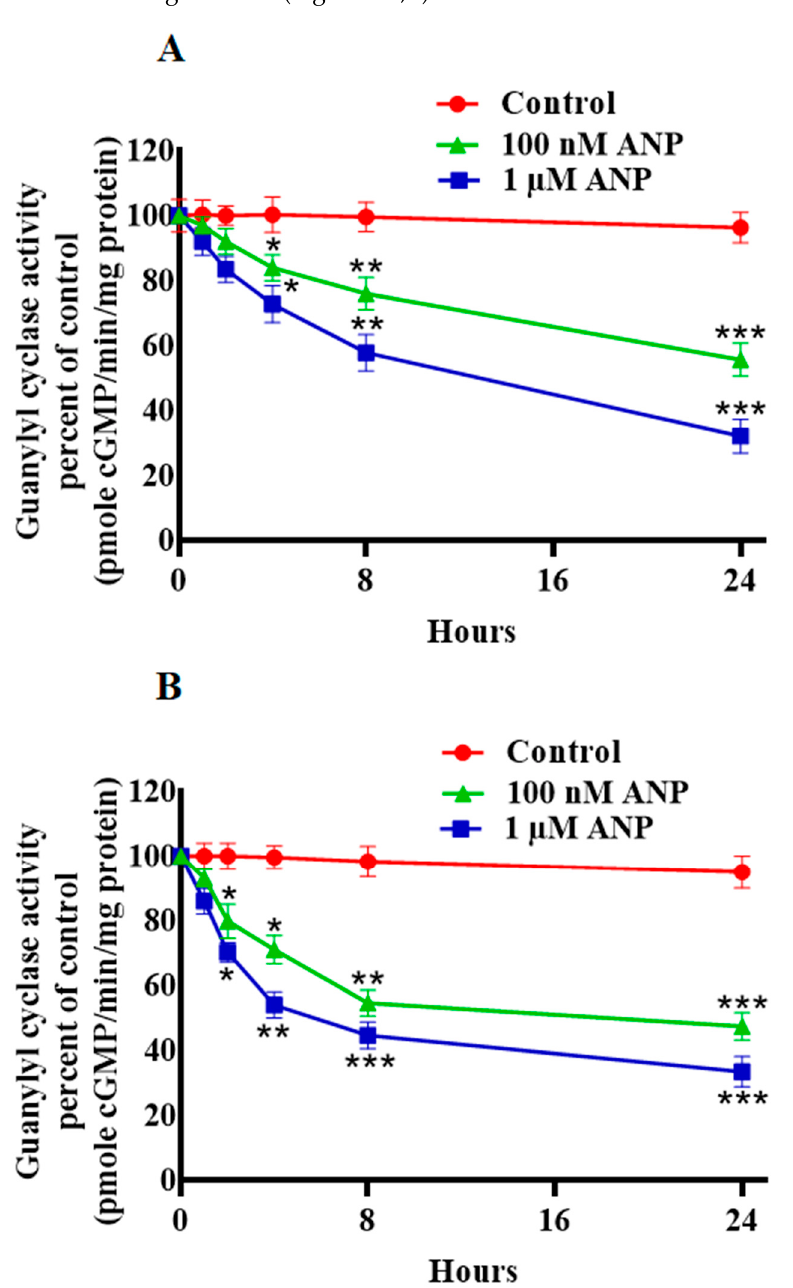
Figure 3. Effect of ANP pretreatment on guanylyl cyclase activity in HEK-293 cells and MA-10 cells. ( A ) HEK-293 cells and ( B ) MA-10 cells were treated with 100 nM ANP for 0, 8, 16, and 24 h. Cells were incubated with glycine acetate buffer (pH 3.8) for 2 min, plasma membranes were prepared. GC activity was determined as described under the section 4. Values represent mean ± SE of 8 independent experiments. * p < 0.05, ** p < 0.01, *** p < 0.001 (untreated vs. drug-treated group).